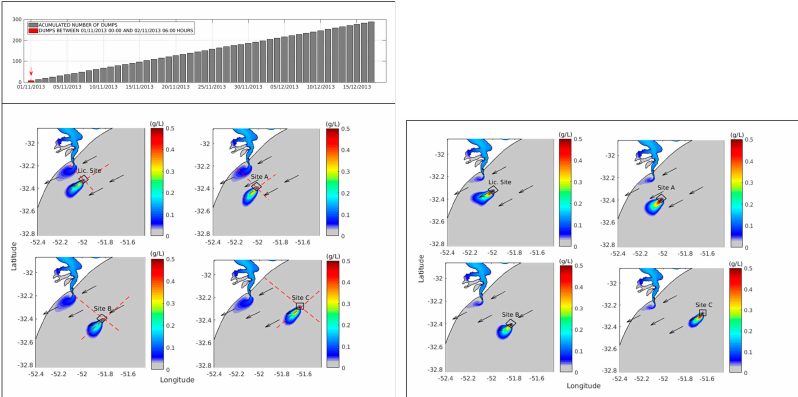
Figure 5. Top panel—Accumulated number of discharges on 2 November 2013 at 06:00 h. Dispersion plume at the surface (central panel) and at the bottom (bottom panel) after 6 discharges on the licensed and alternative disposal Sites A, B, and C. Color scale indicates suspended sediment concentrations (g/L, where gray indicates concentrations lower than 0.025 g/L and red indicates concentrations varying from 0.5–8 g/L. Red dotted line indicates the position of the longitudinal and transversal profiles for which results were extracted. Black arrows indicate the wind direction from the NE. Wind velocity during this event was 11.7 m/s.